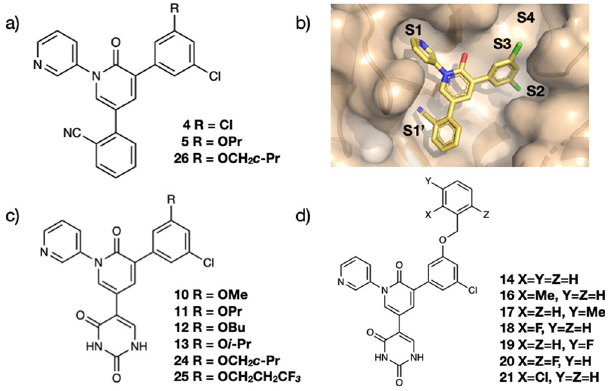
Fig. 3 Structures of the series of cyanophenyl- and uracil-based compounds SARS-CoV-2 main protease (M pro ) inhibitors investigated here. a Cyanophenyl-based M pro inhibitors. b X-ray crystal structure of 4 in complex with the protease, with discussed binding pockets labelled. c , d Uracil-based M